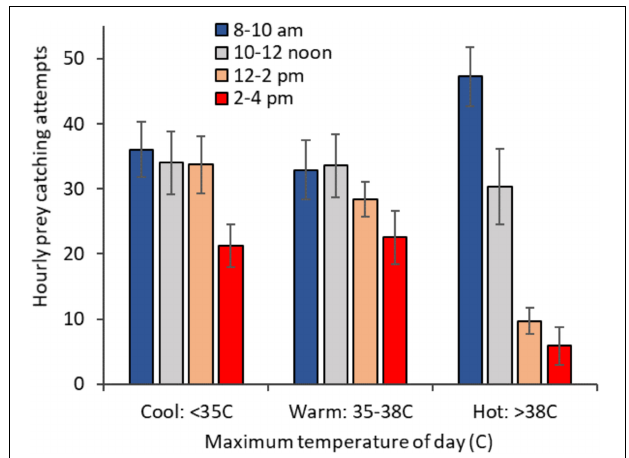
FIGURE 3 | Hourly rate of prey catching attempts by time of day, on days with a maximum temperature that was mild ( < 35 ◦ C, n = 91 observation sessions), warm (35–38 ◦ C; n = 83) or hot ( > 38 ◦ C; n = 71). Error bars show